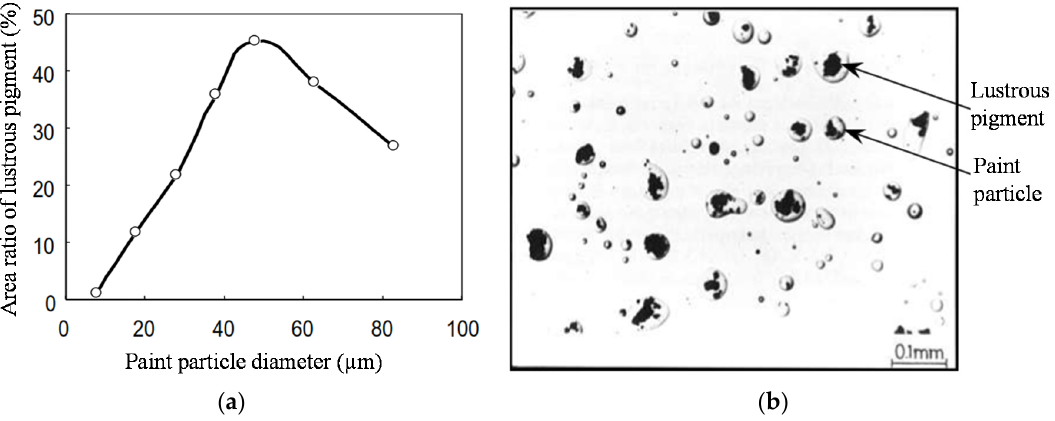
Figure 9. ( a ) Lustrous pigment density in paint particles; ( b ) distribution of lustrous pigment for small, medium, and large paint particles.